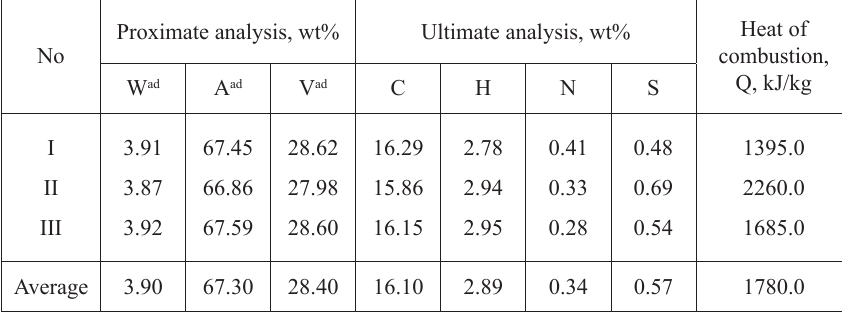
combustion, Q, kJ/kgW ad A ad V ad C H N S 0.41 0.48 1395.0 0.33 0.69 2260.0 2.95 0.28 0.54 1685.0